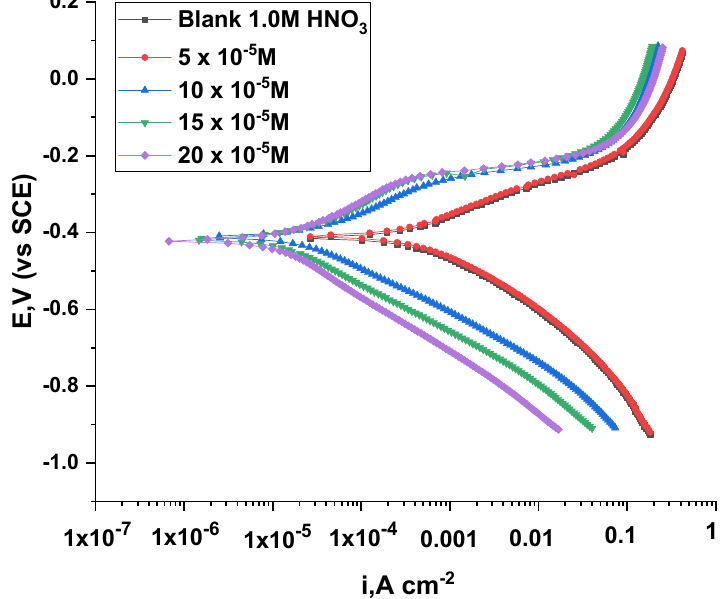
Figure 12. Plots of PP of Cu dissolution with and without different doses of ACR-2.